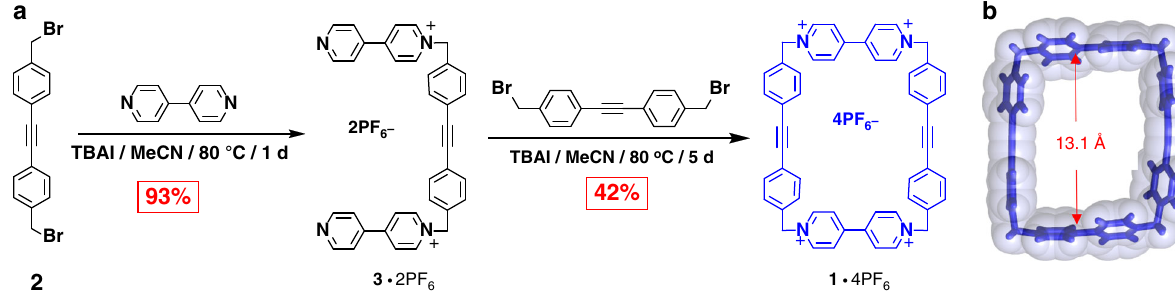
Fig. 2 Synthesis and crystal structure. a Synthesis of 1· 4PF 6 and b solid-state structure of 1 4 +